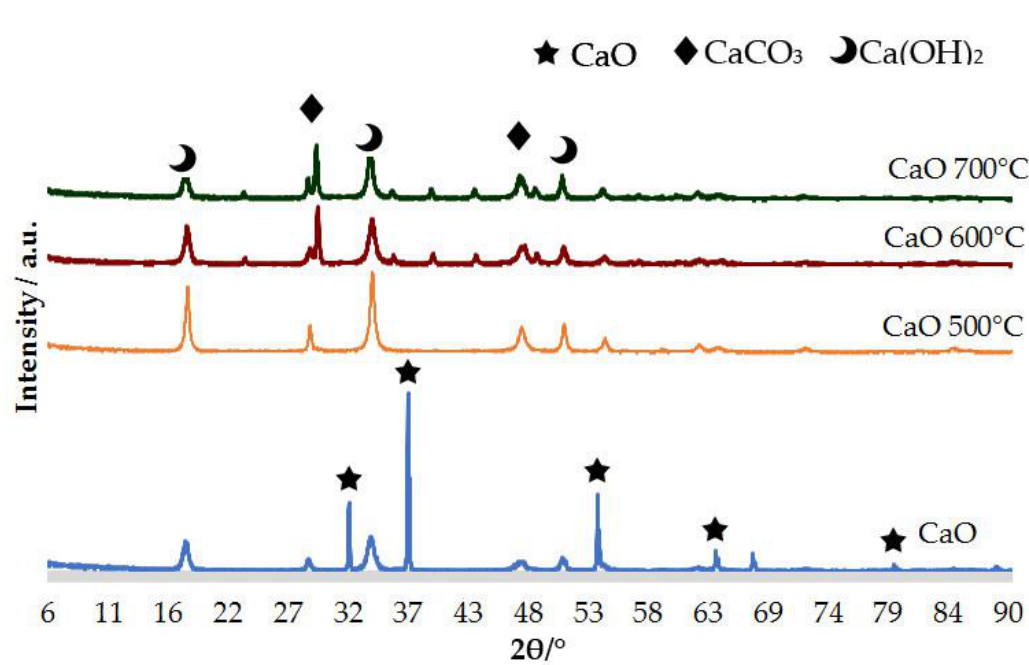
ff raction (XRD) patterns of fresh and after processes CaO Figure 12. X-ray diffraction (XRD) patterns of fresh and after processes CaO sorbent. Figure 12. X-ray di